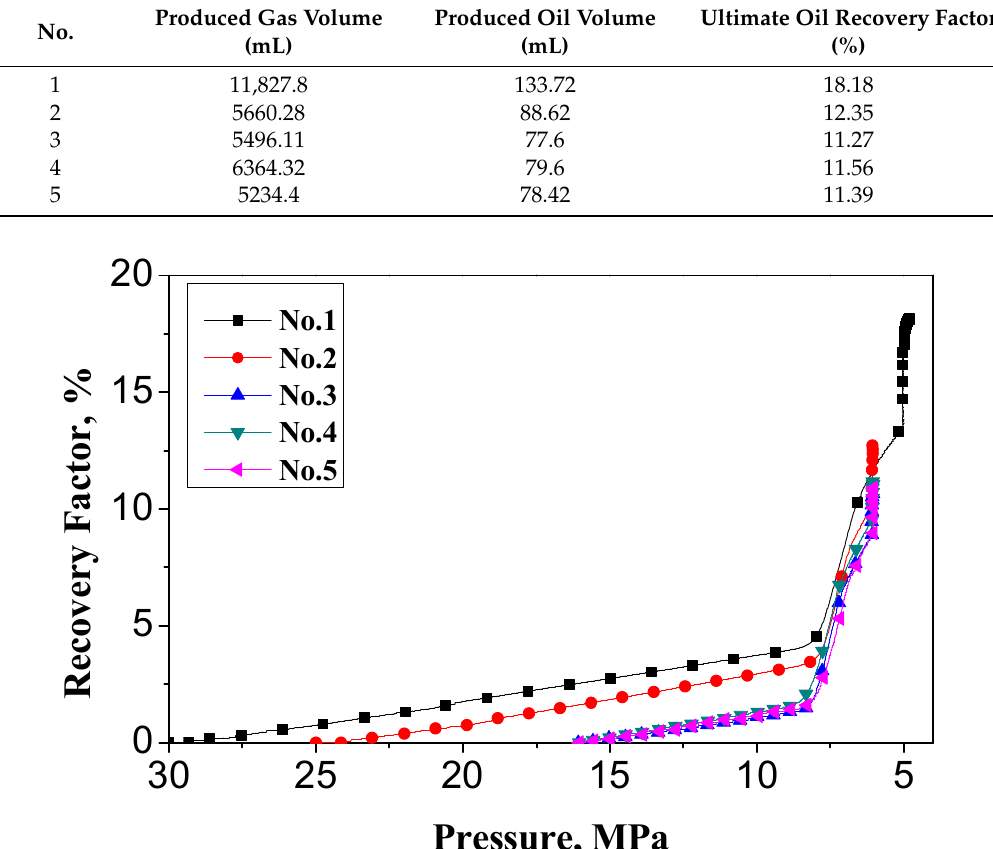
Figure 9. Recovery factor of live oil depletion under different pressure coefficient.